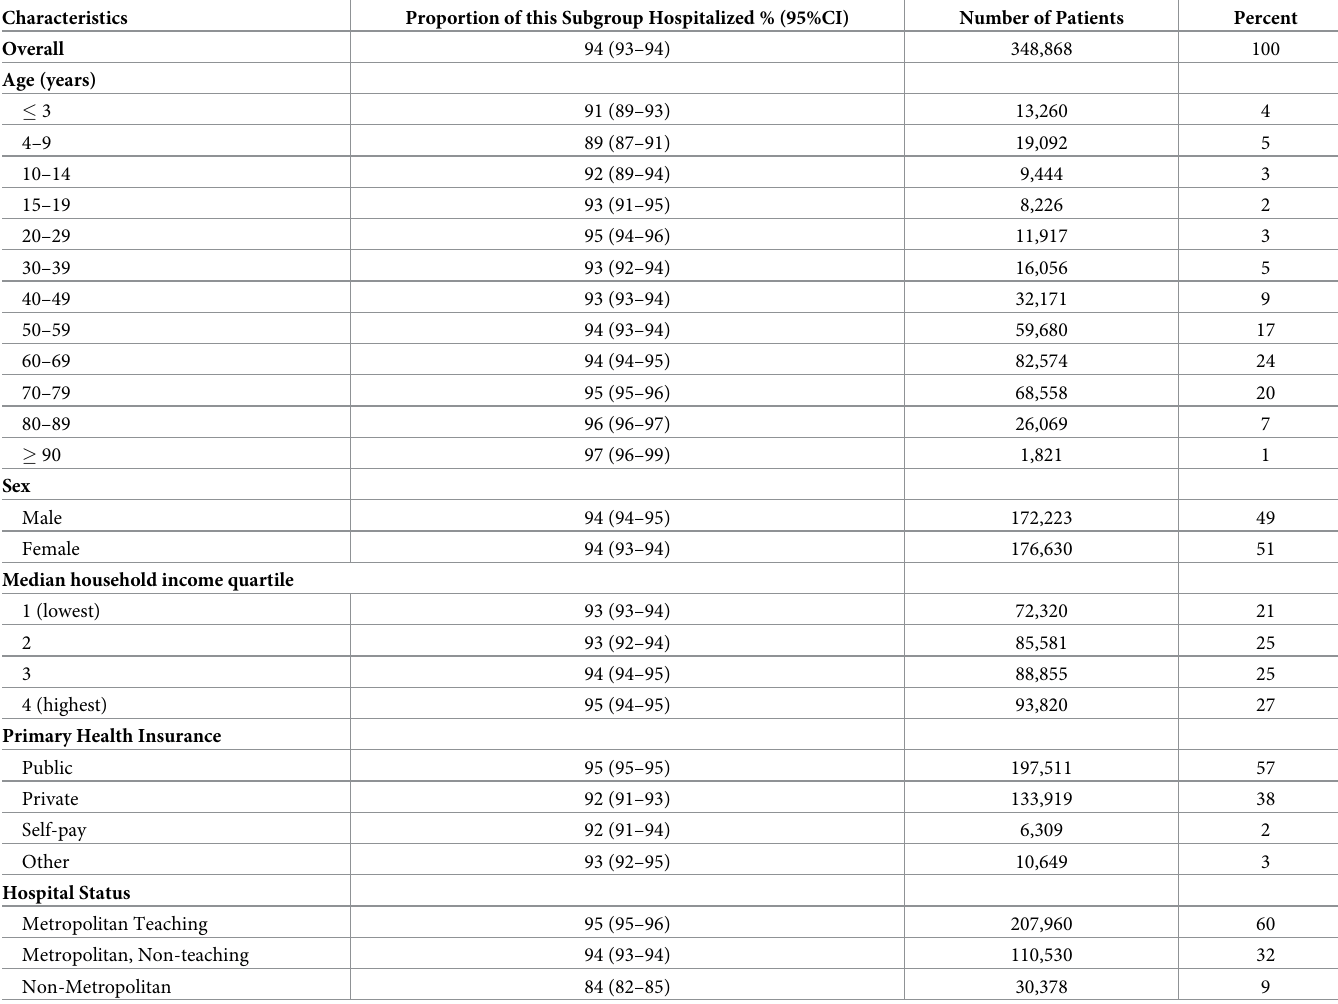
Table 1. Characteristics of US ED febrile neutropenia visits,